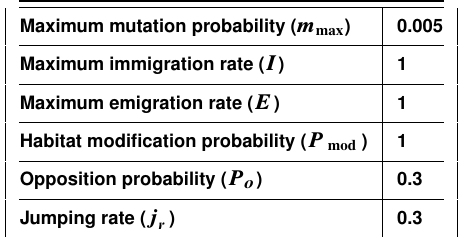
Table 3. Suggested GOBBO control